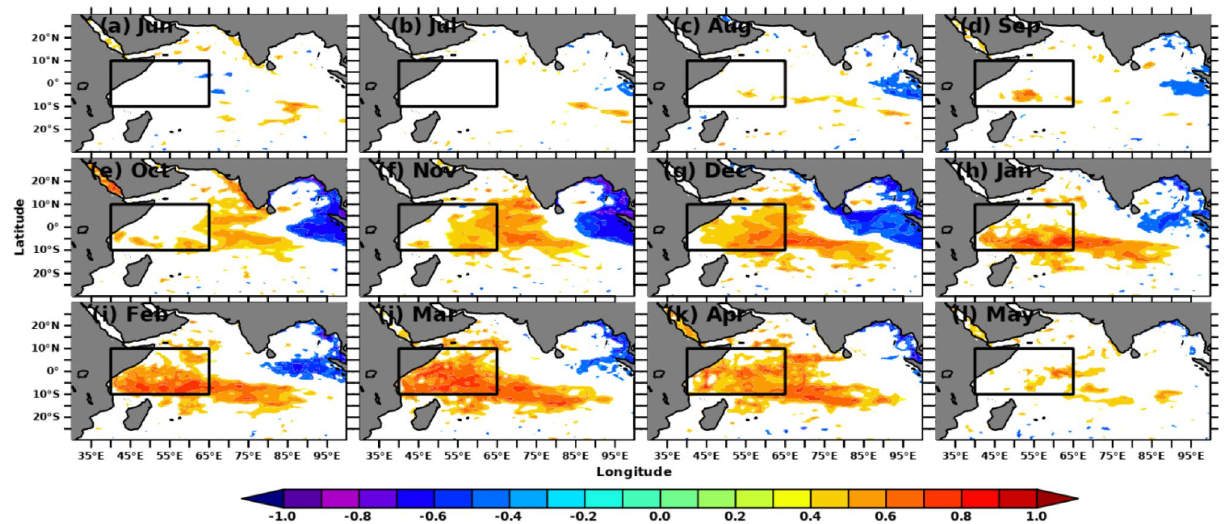
Figure 3. Simultaneous monthly correlations between detrended Indian Ocean MSLA and Nino3.4 SSTA indices. Areas of correlations at 95% significance are shown. The figure is generated using PyFerret